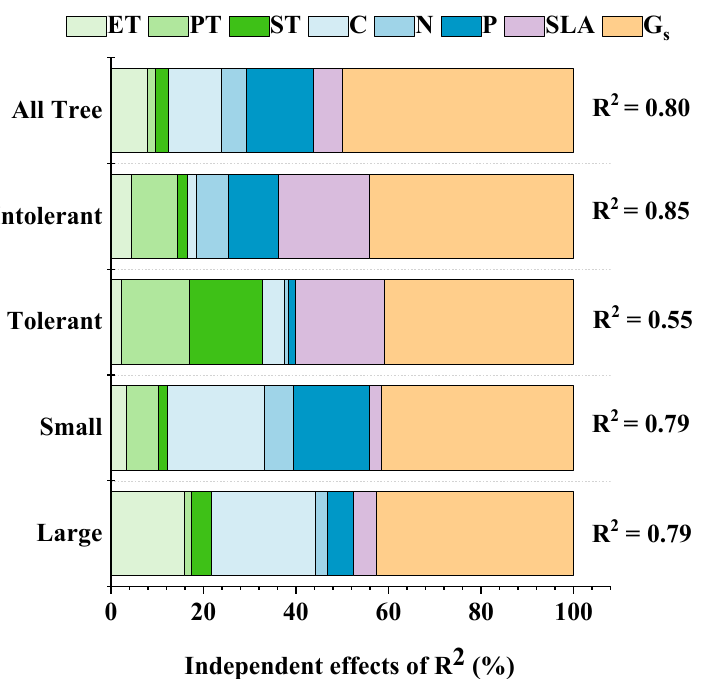
Figure 2. Contribution of leaf traits to P n variation. The meanings of abbreviations are shown in Table